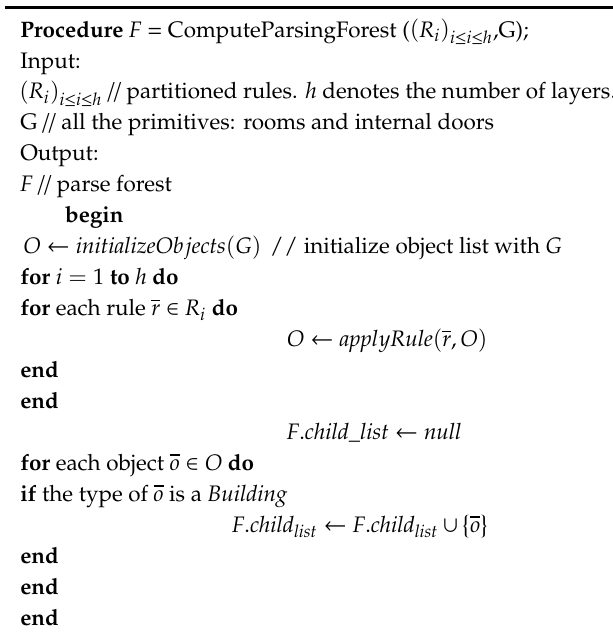
Figure 8. Pruning incomplete trees from parse forest.